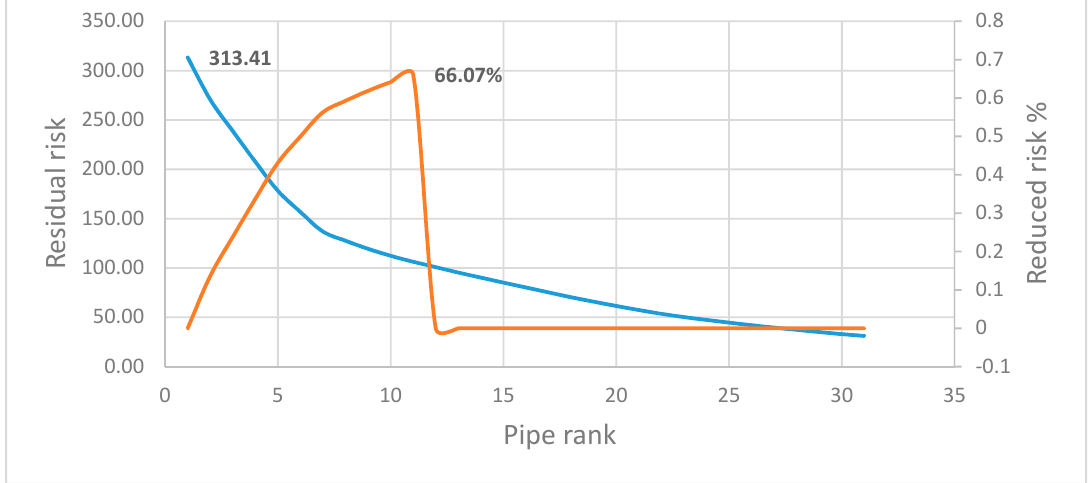
Figure 11. Cumulative risk reduction evaluated based on the target replacement percentage of pipe in the masterplan calculated for the first year